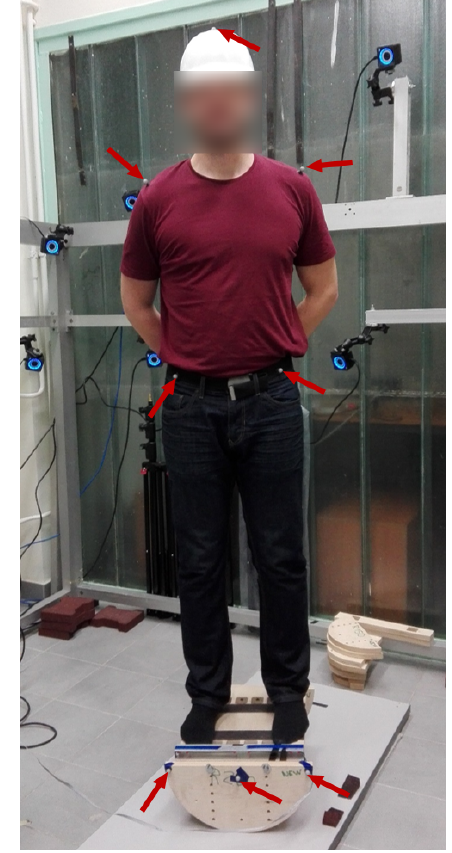
Figure 2. Balancing task, measurement setup. Fig. 3. The passive stiffness s